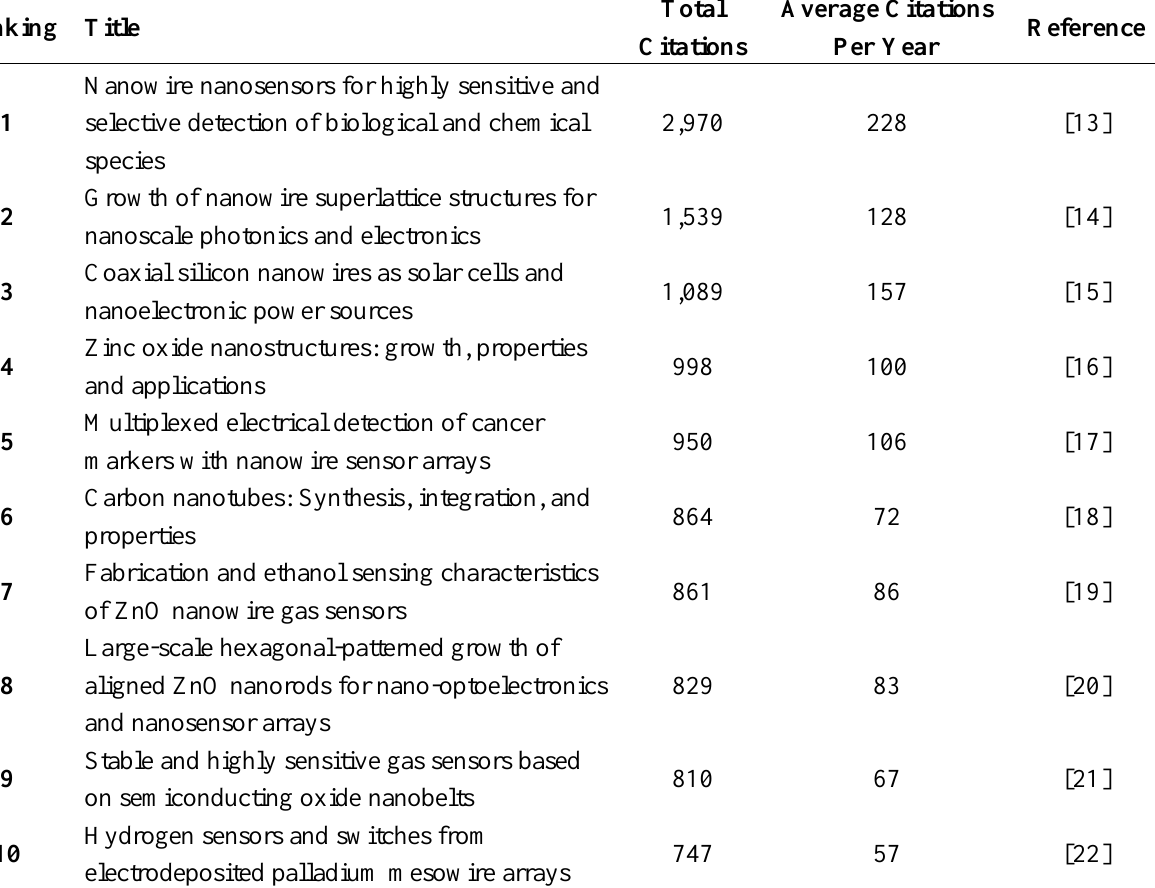
Table 1. Top ten most cited articles in the topic nanowire* sensor* or nanorod* sensor* or nanobelt* sensor* (IsiWebofKnowledge, 10 June